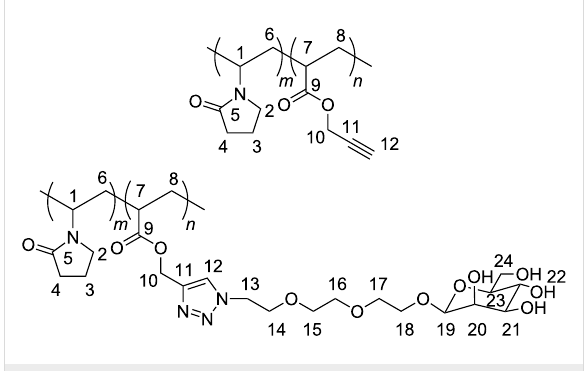
Figure 4: Hydrogen and carbon numbering for NMR assignment.